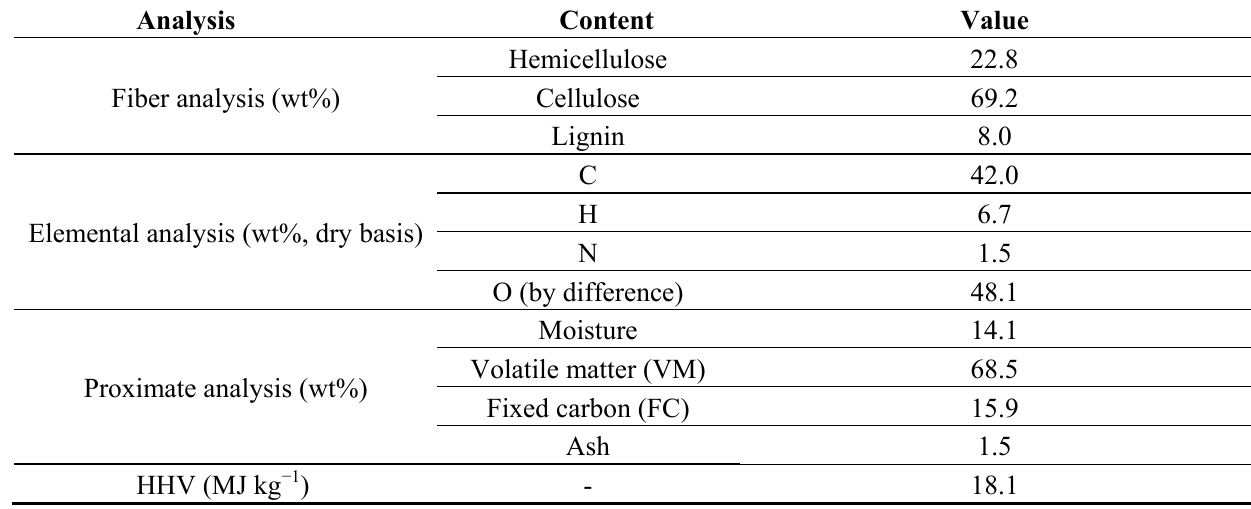
Table 1. Basic properties of raw corncob waste. HHV: higher heat value.